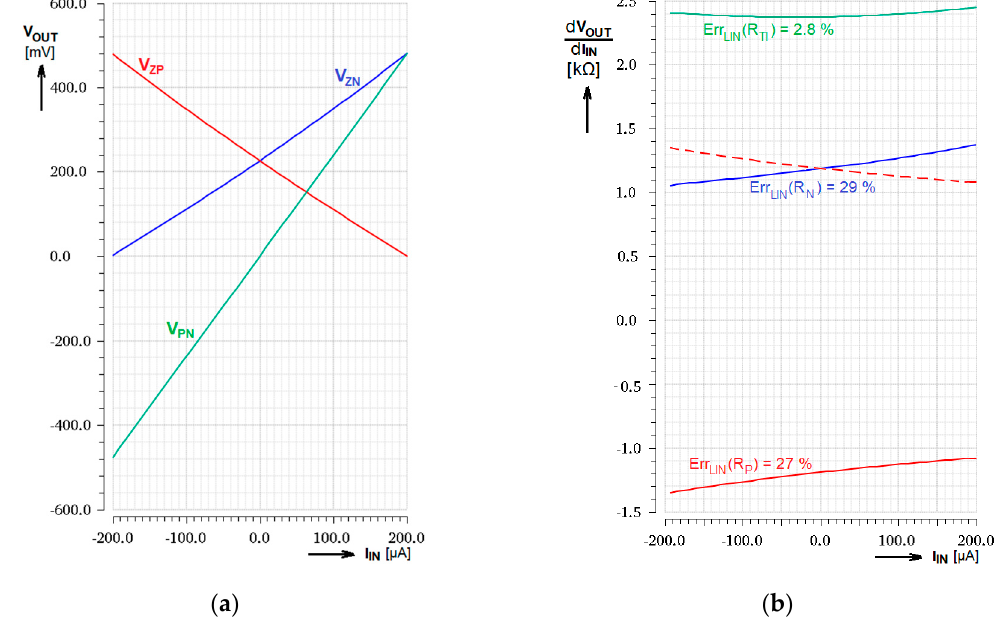
Figure 4. Simulated transimpedance response of the input stage ( a ) Output voltages as the function of